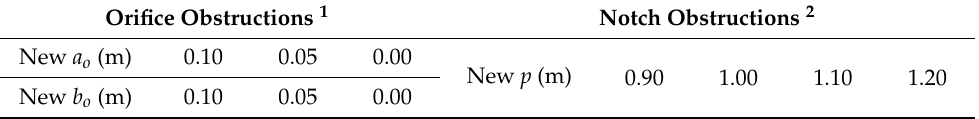
Table 1. Geometrical modifications in each of the cross-walls to simulate different obstructions events. Orifice Obstructions